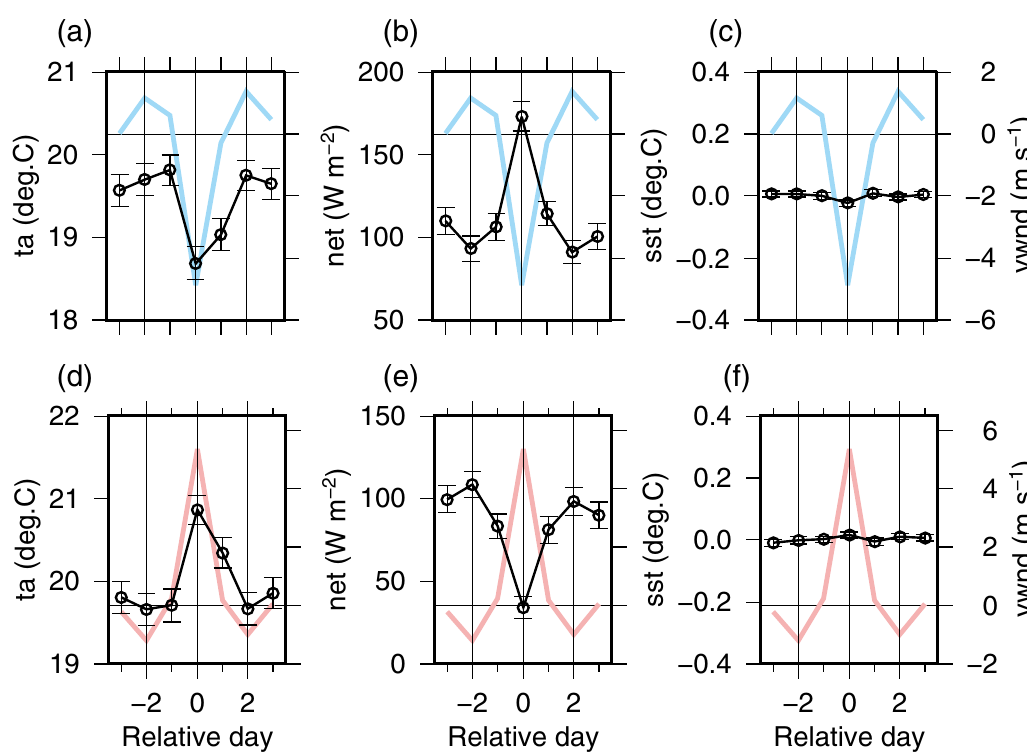
Figure 4. Same as Fig. 3, but for KEO. The figures for other components of flux and the related variables are shown in Supplementary Fig. S6 and